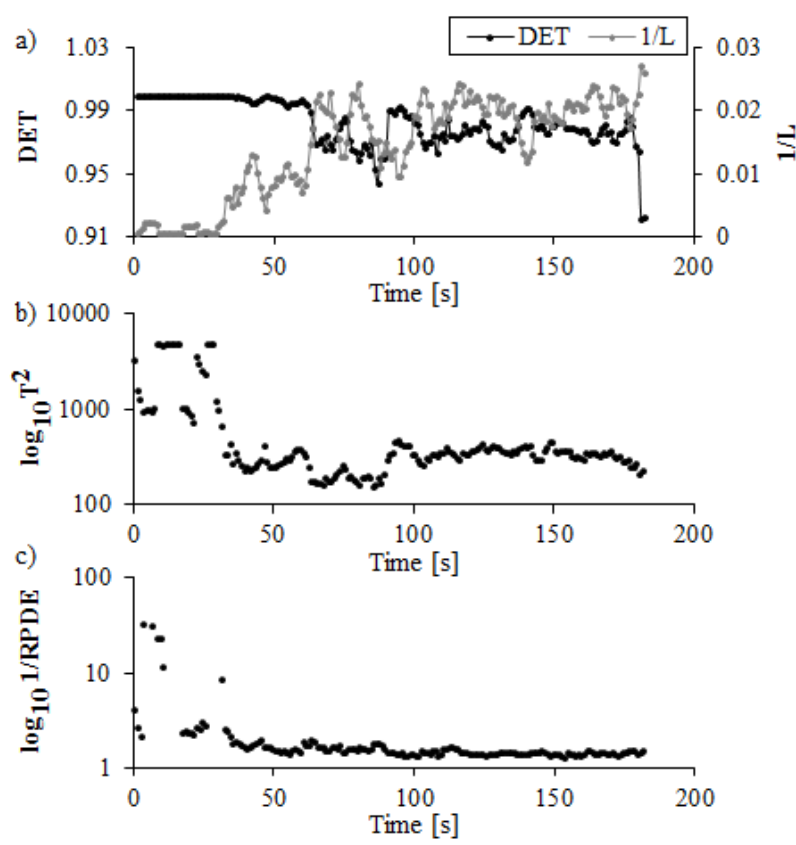
Figure 5. Changes of coe ffi cients: ( a ) DET , 1 / L, ( b ) T 2 , ( c ) 1 / RPDE ( m = 4, τ = 100, ε = 0.8 σ ) in time. The calculations have been made using the CRP toolbox for Matlab ®